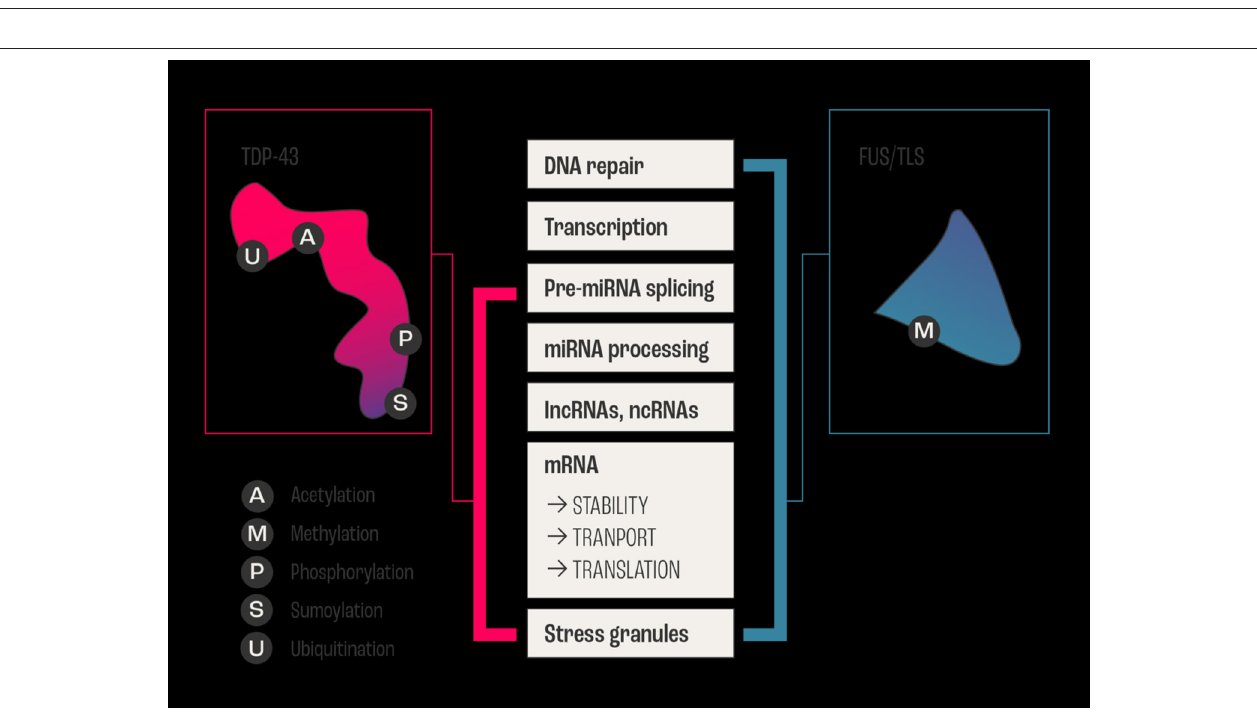
FIGURE 2 | Example of overlapping and intersecting functional duties of two major RNABPs. The two major RNA Binding Proteins FUS/TLS and TDP-43 are involved in ALS, and they share regulating all aspects of RNA (metabolism, biogenesis, and life cycle) from transcription, processing, and transport/stability to the formation of cytoplasmic and nuclear stress granules. In addition to vital biochemical processes such as acetylation, sumoylation, ubiquitination, methylation, and phosphorylation within neurons. The schematic diagram shows the sharing and distribution of molecular functional between these two major proteins.